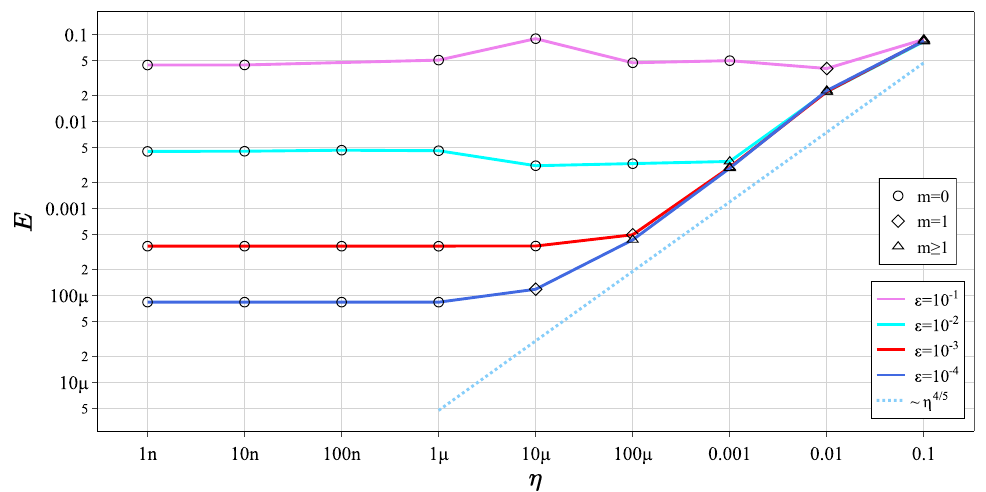
/ u 0 as a function of the u u | − ∗ | is the theoretical ∗ 2 π 2 t / Re is the reference velocity. The plot is − ε = 1, 2, 3, 4. In all cases, the maximum level of (cid:0) (cid:1) 10 − − − −